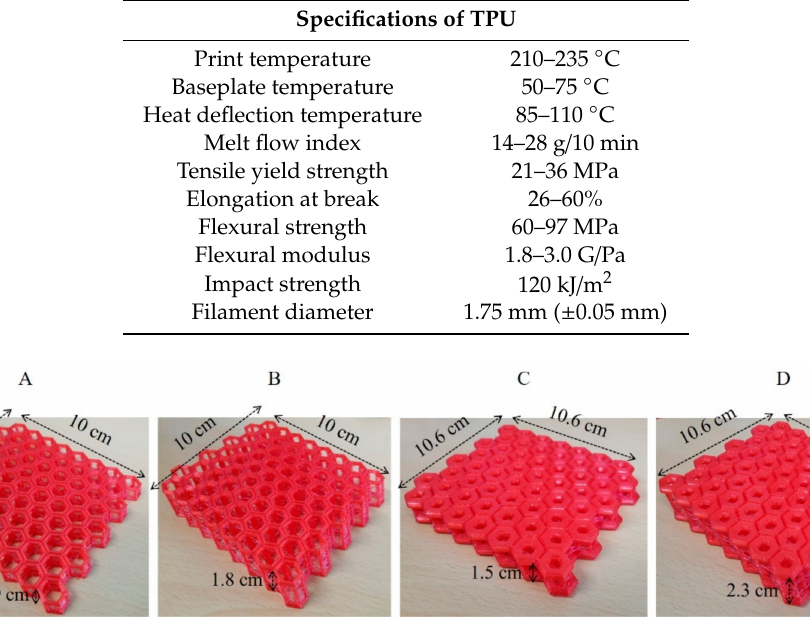
Figure 2. Four types of technical materials.